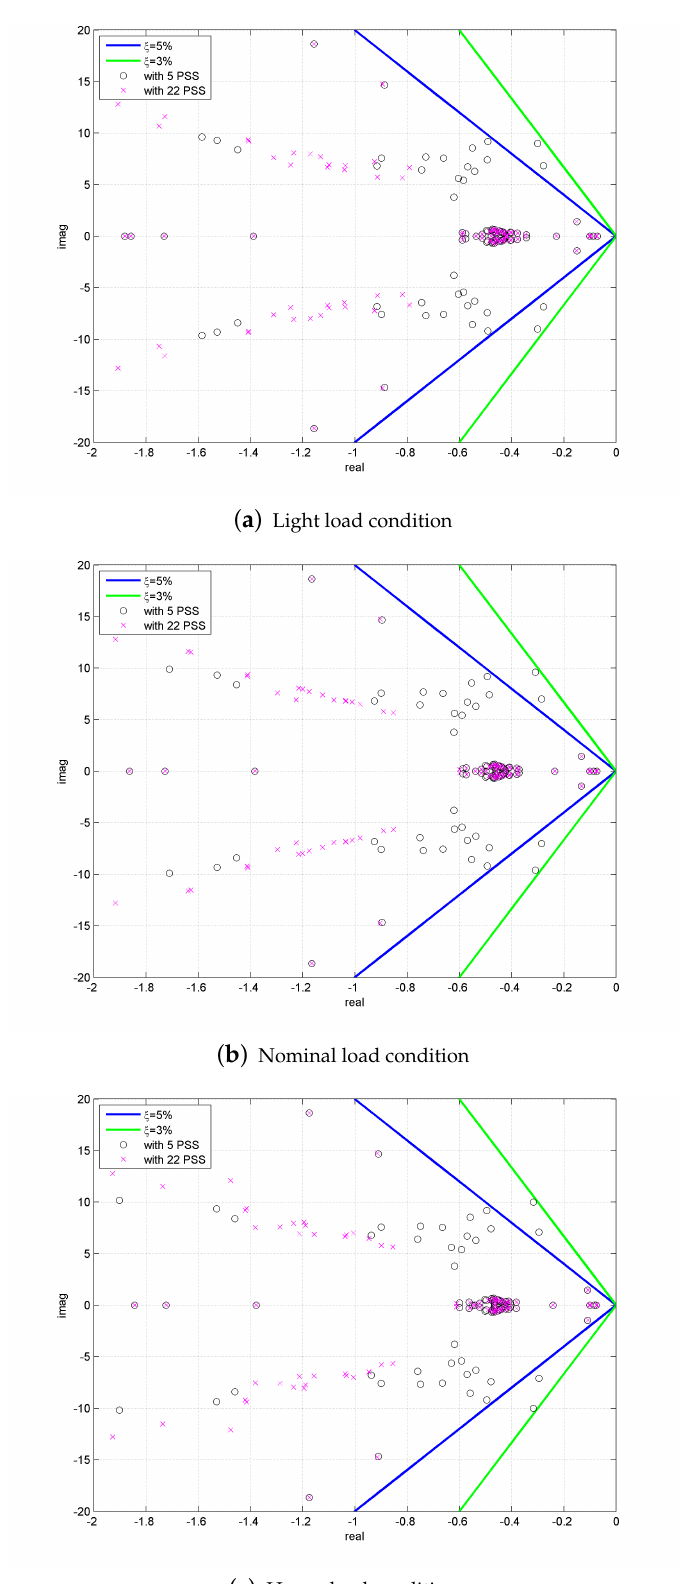
Figure 14. SING under different load